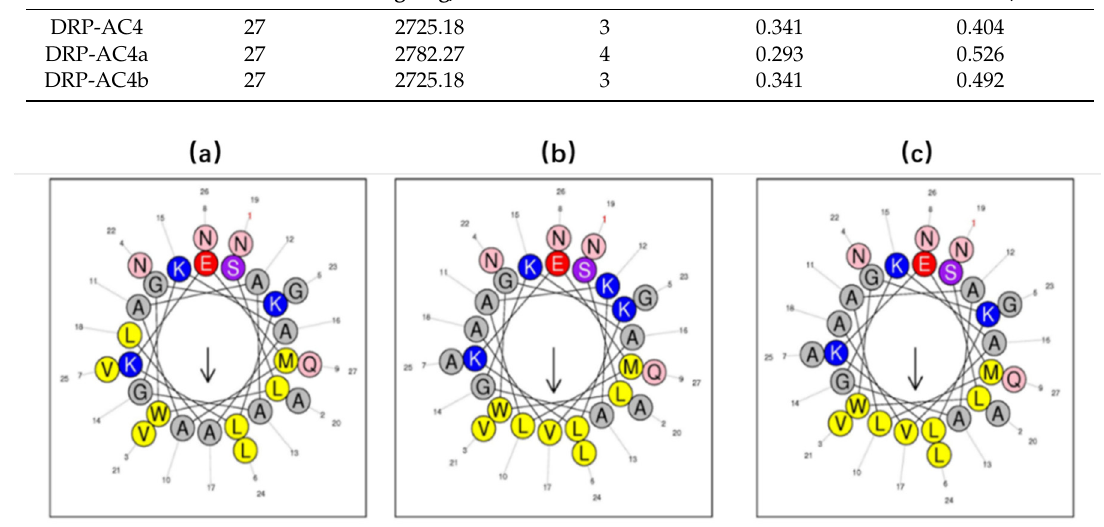
Figure 5. Predicted helical wheel projections of DRP-AC4 ( a ), DRP-AC4a ( b ) and DRP-AC4b ( c ). Table 1. Physiochemical properties of DRP-AC4, DRP-AC4a and DRP-AC4b predicted by the Heliquest online website.